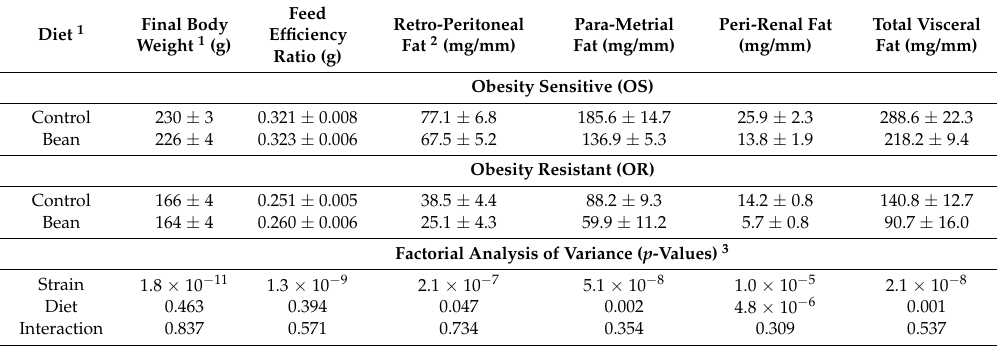
Table 3. Effect of paired-feeding of commercially processed bean powder on food efficiency ratio and visceral adiposity.